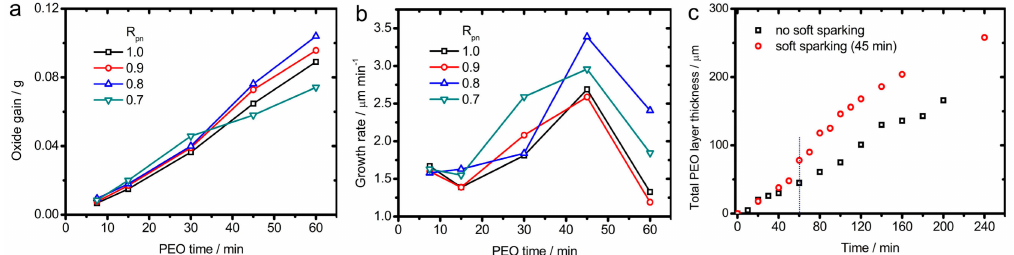
Figure 6. Oxide ( a ) mass gain and ( b ) growth rate of PEO with R pn = 1.0, 0.9. 0.8, 0.7 at controlled current 10 A · dm − 2 , the voltage–time curves of which are plotted in Figure 2a [40]. ( c ) Thickness of two PEO coatings with R pn = 0.89 (red) and 1.57 (black) at controlled current 38 A · dm − 2